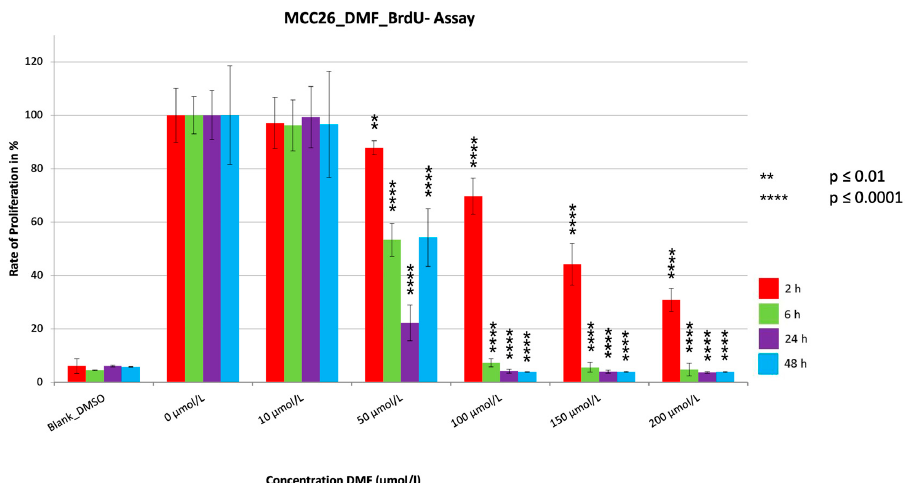
Figure 6. Cell proliferation measurements of the cell line MCC26 with a cell concentration of 50.000 cells/well with the addition of the substance DMF in different concentrations (10–200 µmol/L). Values are expressed as the mean ± SD of eight technical replicates. A multiple comparison test following the ANOVA was used to test whether there were significant differences between the individual mean values and the mean value of the normal control.